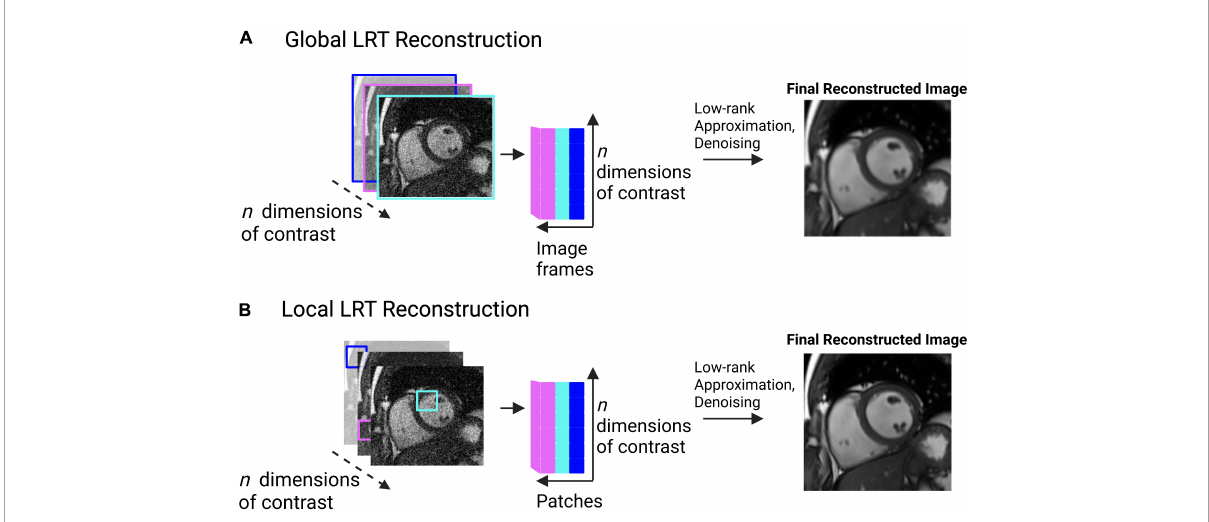
FIGURE6 (A) Pictorial example of global low rank tensor (LRT) methods. This global method looks for image redundancy between entire image frames. This pictorial shows image frames identified across multiple image contrasts (e.g., T1, T2, etc.). Correlations are sought between the image frames, represented by the cartesian plane. Low-rank approximation and denoising are then applied to produce a final, reconstructed image. Spatial blurring or artifacts may be present in the resulting image due to the possibility of multiple tissue types being present in the image frame. (B) Pictorial example of local low rank tensor methods. This method breaks an image frame into “patches” and looks for image redundancy across image patches. The patches are unfolded in a matrix and a tensor is formed. Tensor decomposition through low-rank approximation allows for the image to be denoised, producing a final, reconstructed image. This method retains more detail information than the global method, as patches are more likely to contain a single tissue type, with a single contrast.